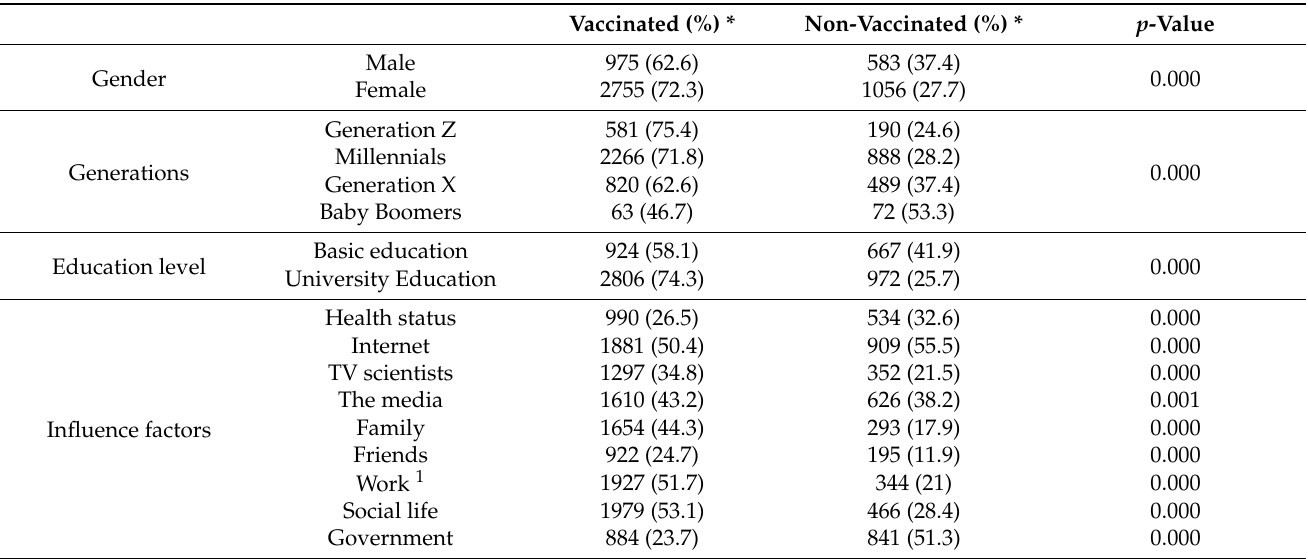
Table 2. Vaccinated and Non-Vaccinated people among genders, generations, and the influence factors, n = 5369.